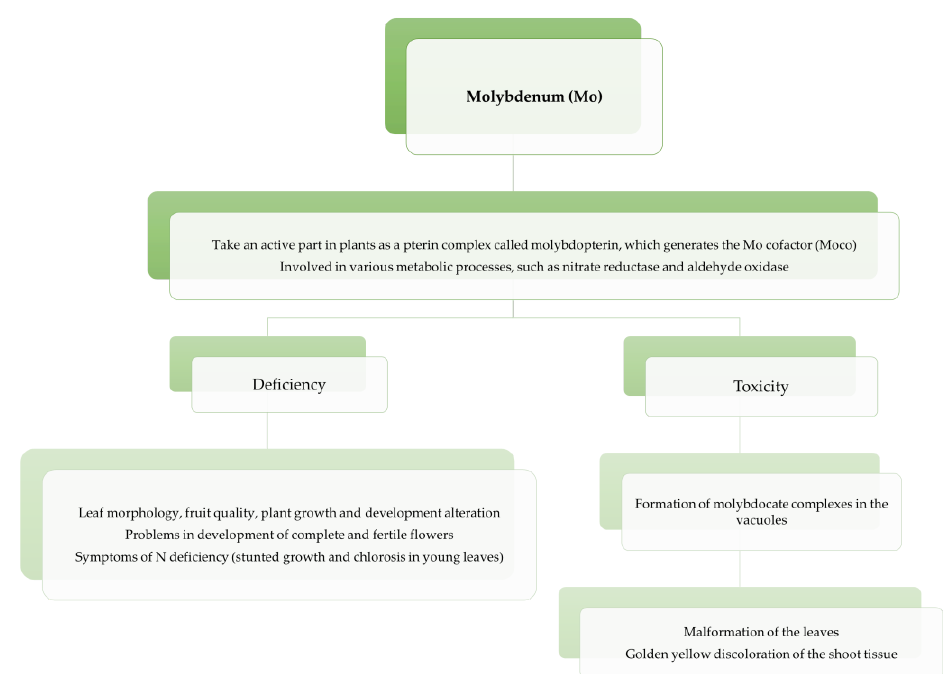
Figure 3. Main effects of molybdenum (Mo) in plants.